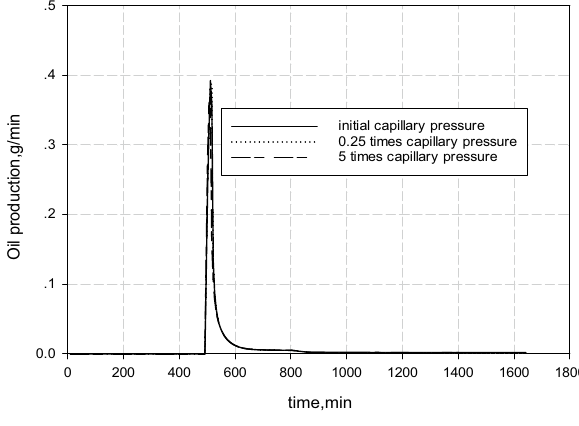
Fig. 11 Oil production rate curve under different capillary pressures (experiment 2) Table 4 Capillary pressure function parameters in the CO